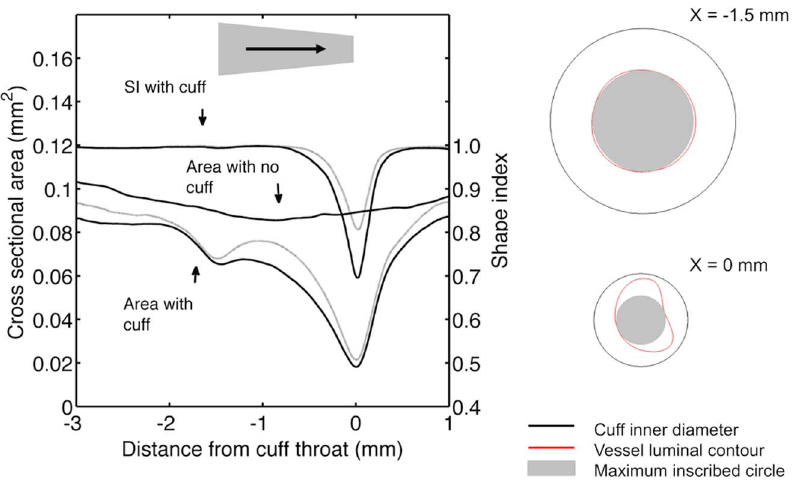
Fig. 2. Geometry of cuffed vessels. Left. Cross sectional area and shape index of the left carotid lumen in mice with the cuff in the conventional direction. The location and orientation of the cuff with respect to the x- axis are shown by the shaded area; the arrow indicates the mean flow direction. Shape index 5 1 for a circle and 0 for a line. Mean (dark line) + 1 SEM (light line), n 5 3. For comparison, the cross sectional area of one uncuffed left carotid is also shown. Right. Cross sections at the upstream (x 52 1.5 mm) and downstream (x 5 0 mm) ends of the cuff, showing the cuff inner diameter, the luminal contour of the vessel, and the maximum inscribed circle that can be fitted within the lumen.